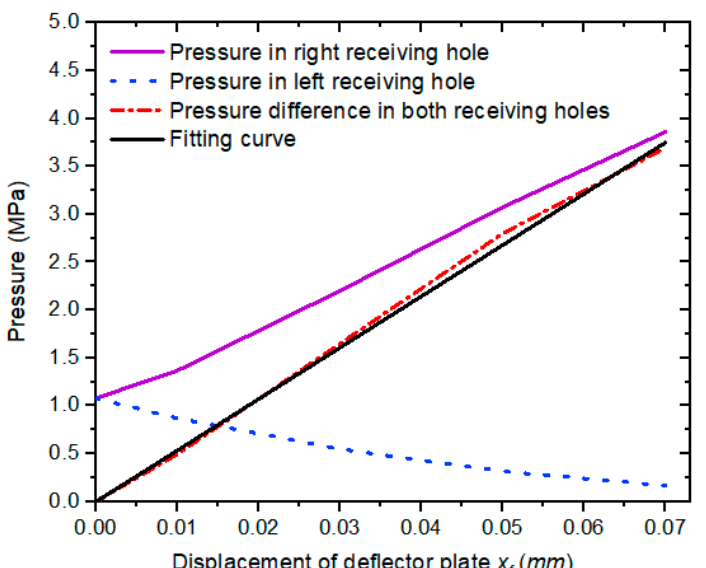
Figure 9. The pressure and pressure difference in receiving holes with movement of the deflector.